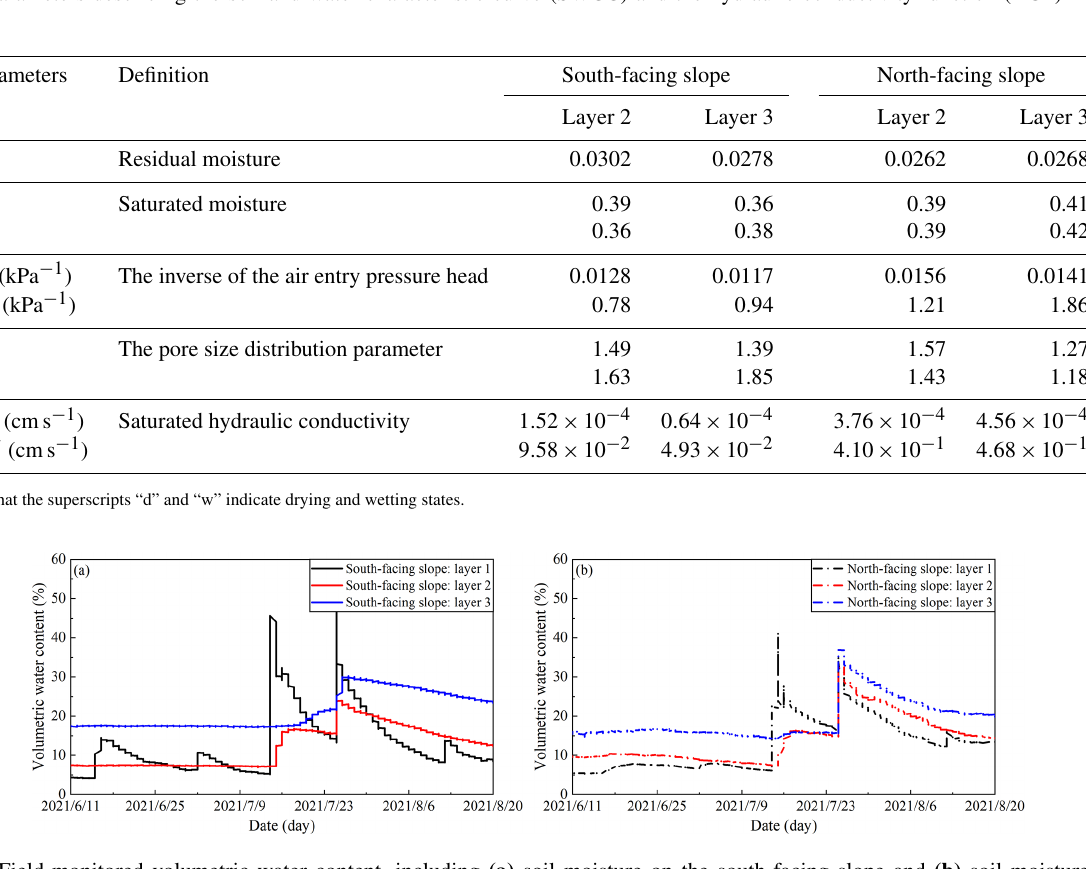
Figure 9. Field-monitored volumetric water content, including (a) soil moisture on the south-facing slope and (b) soil moisture on the north-facing